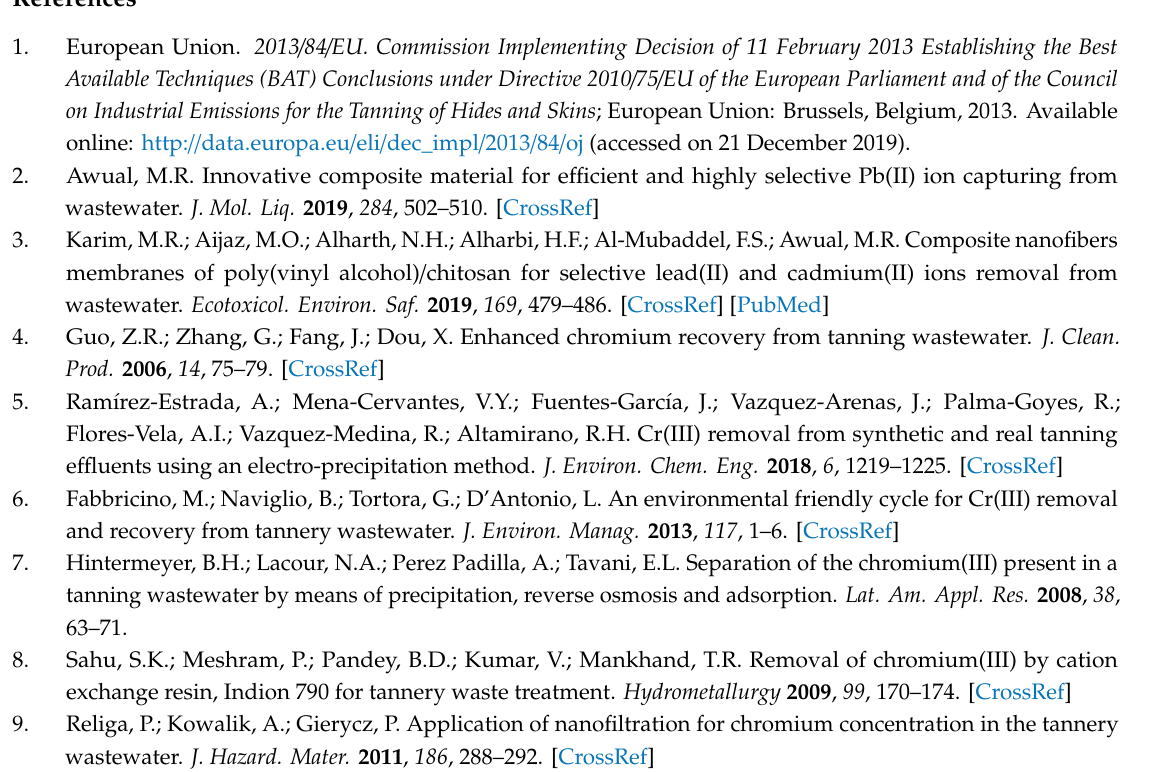
Figure S1: Speciation forms of Cr(III) using H 2 SO 4 as leaching agent and applying the equilibrium data of this study, according to software Visual MINTEQ version 3.1. Figure S2: Speciation forms of Cr(III) using HNO 3 as leaching agent and applying the equilibrium data of this study, according to software Visual MINTEQ version 3.1. Figure S3: Speciation forms of Cr(III) using HCl as leaching agent and applying the equilibrium data of this study, according to software Visual MINTEQ version